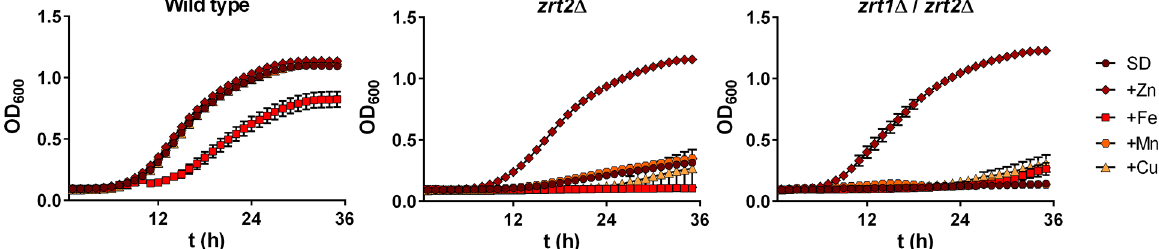
Fig 4. Growth of zrt2 Δ strains is specifically rescued by excess zinc. Indicated strains were cultured as in Fig 1 with zinc, iron, manganese (100 μM) or copper (10 μM) and growth kinetics measured over 36 h in a microtitre plate. Experiment performed twice in triplicate. Iron had a moderate inhibitory effect on C . albicans growth. Note that only zinc rescued growth of zrt2 Δ strains.